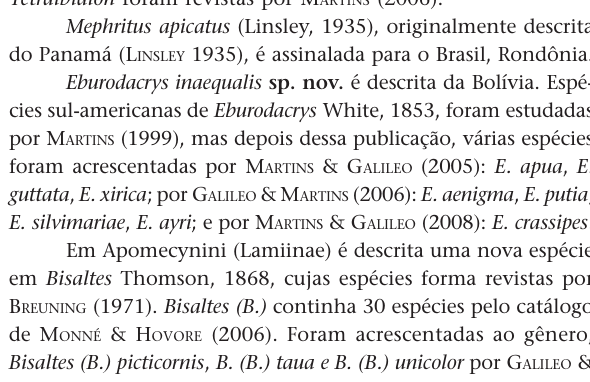
Cabeça, escapo e pedicelo laranja-avermelhados. Pernas pretas. Fronte e vértice sem pubescência. Tubérculos anteníferos bem projetados com ápice arredondado. Escapo sem sulco interno e sem projeção externa no ápice. Protórax laran- ja-avermelhado. Partes laterais do protórax muito